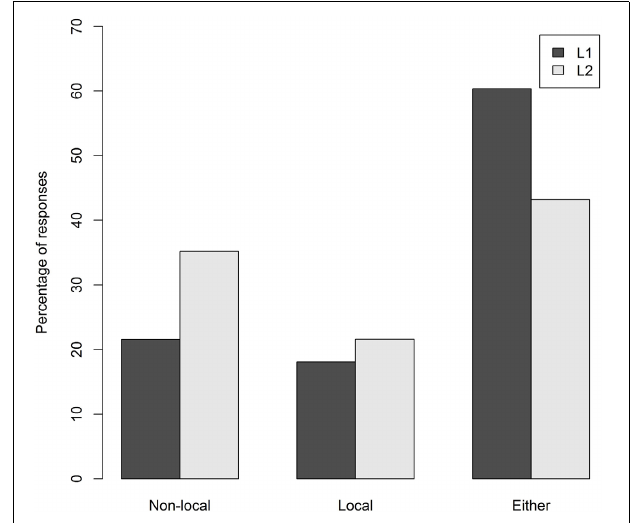
FIGURE 1 | Percentage of responses per group to the canonical condition B structures. FIGURE 2 | Percentage of responses per group to the SDP